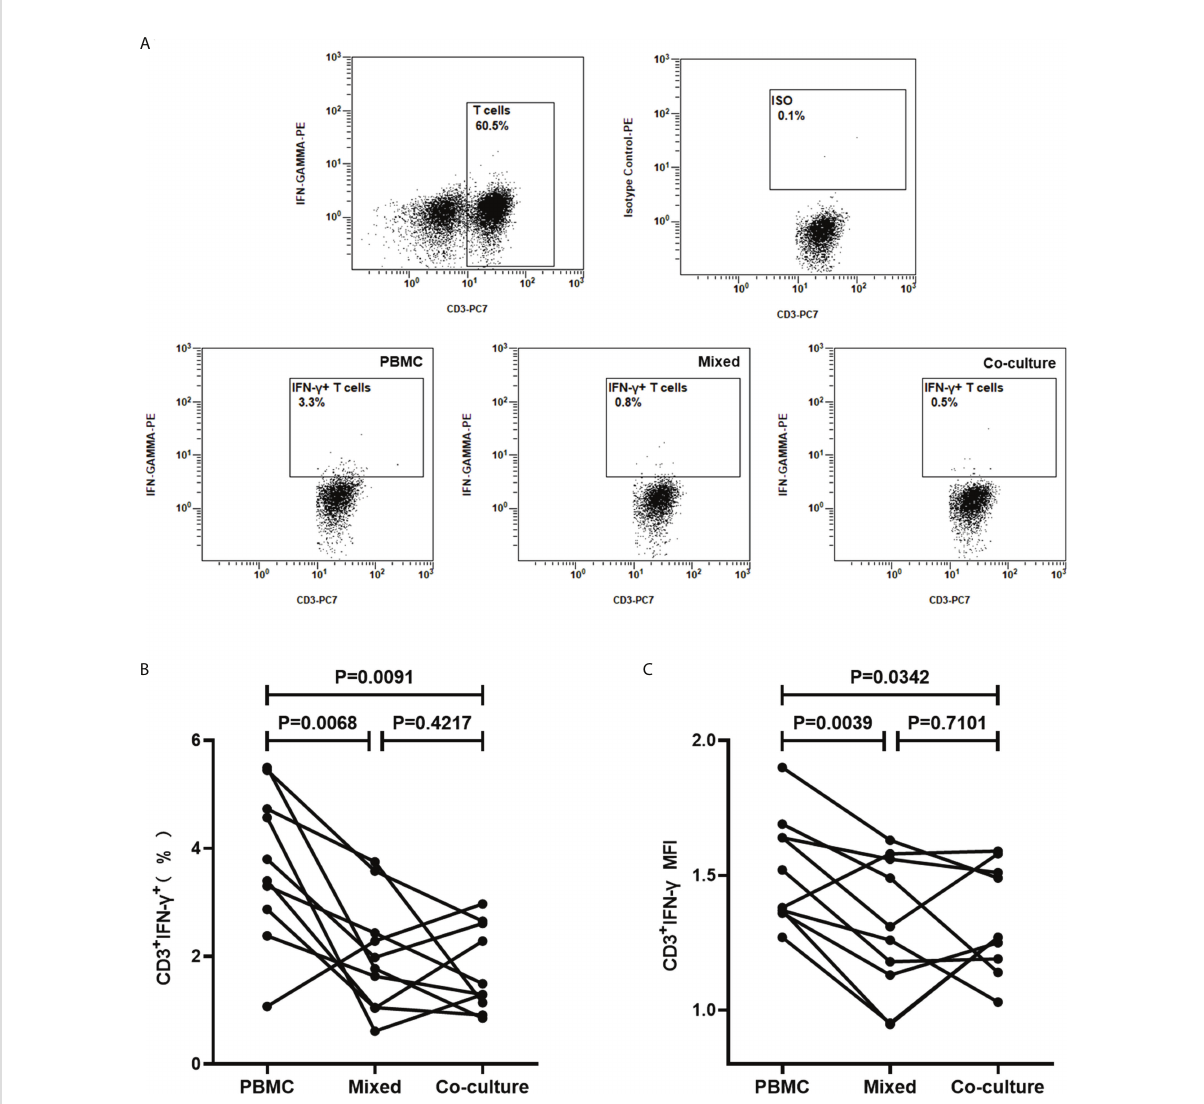
FIGURE 8 Platelets suppress IFN- g production in T cells in a non-contact-dependent manner. PBMCs were cultured and stimulated with PHA for 16 h, in the absence of platelets (PBMC), or the presence of platelets in mixed culture system (Mixed) or co-culture system (Co-culture), followed by the detection of the intracellular IFN- g in T cells by FCM (n=10). (A) Representative fl ow cytometry scatter plots of IFN- g production in T cells. (B, C) The frequencies of IFN- g -producing T cells and the MFI of three groups were compared by paired Student ’ s